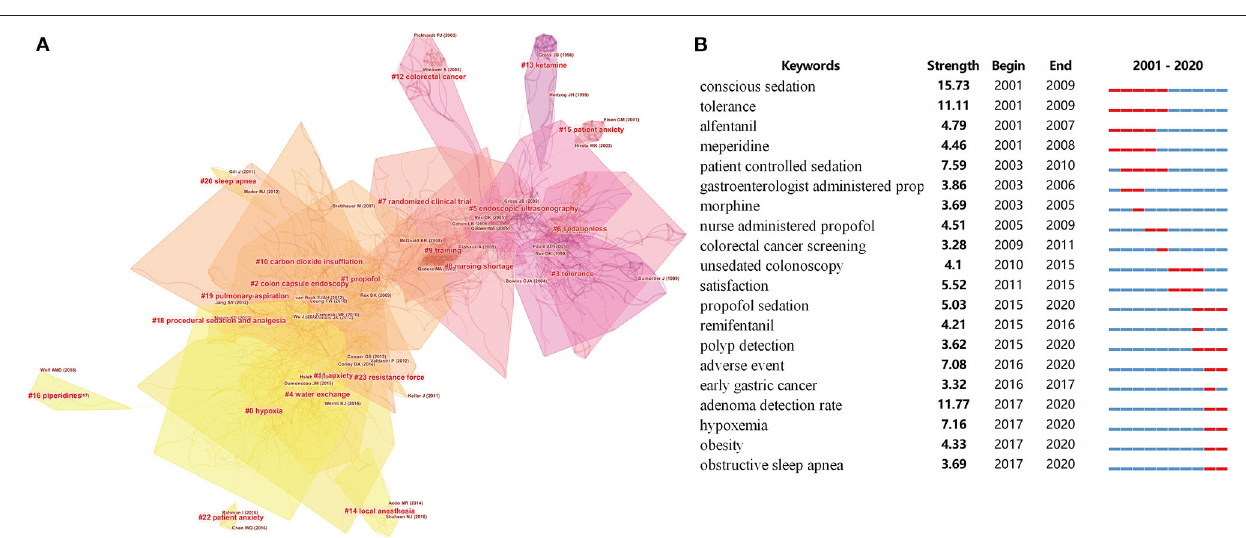
FIGURE 7 | The clustered network map of co-cited references on Endoscopic Sedation. (A) Keywords with the strongest citation bursts in original articles on Endoscopic Sedation research between 2001 and 2020 (B) .